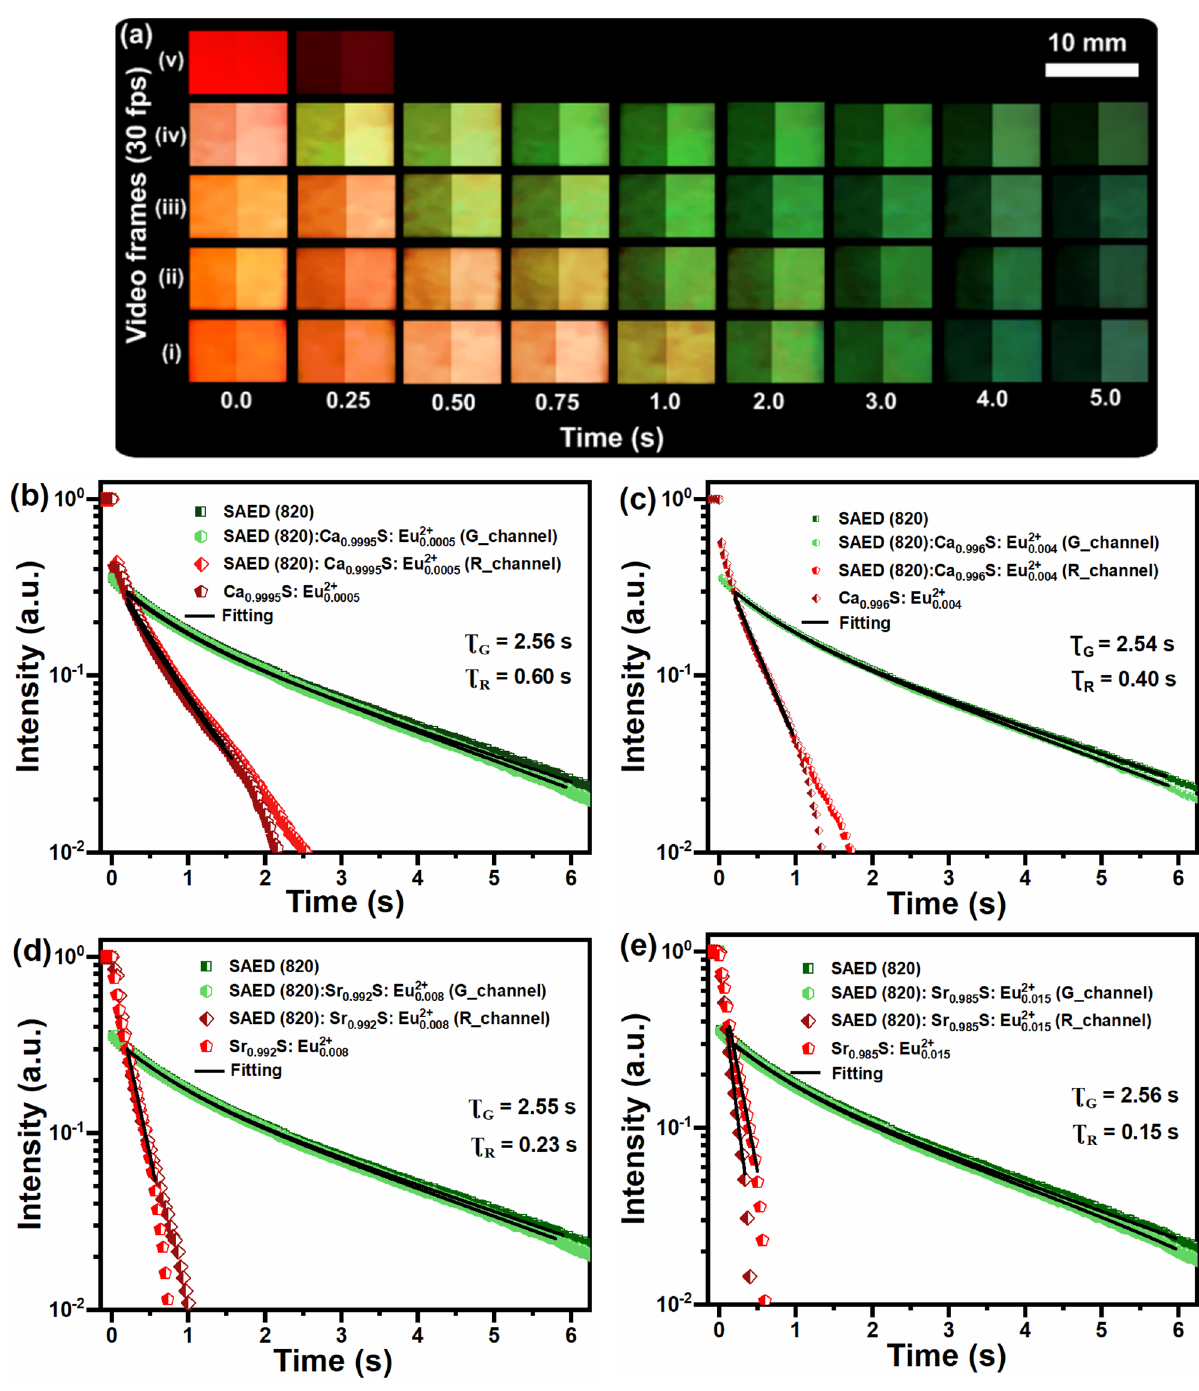
Figure 3. Tuning change of emission color and persistent lifetime of blended phosphors. (a) Illustration of color tuning with time using blends of different red and green persistent phosphors. The left half of each image shows the raw video frame (change in color and intensity), the right half highlights the color 2 + change only by normalizing to a constant intensity. The compositions are: (i) SAED (820): Ca 0.9995 S:Eu 0.0005 2 + Sr 0.992 S:Eu 2 + Sr 0.985 S: Eu 2 + (ii) SAED (820): Ca 0.996 S:Eu 0.004 (iii) SAED (820): 0.008 and (iv) SAED (820): 0.015 at 95:5 wt.%. The longer the persistent lifetime of the red phosphor the longer the transition takes and vice- 2 + versa. The extracted red and green channels persistent lifetime of phosphors: (b) SAED (820): Ca 0.9995 S:Eu 0.0005 , 2+ Sr 0.992 S:Eu 2 + Sr 0.985 S:Eu 2 + (c) SAED (820): Ca 0.996 S:Eu 0.008 and (e) SAED (820): 0.015 alongside 0.004 , (d) SAED (820): the pure